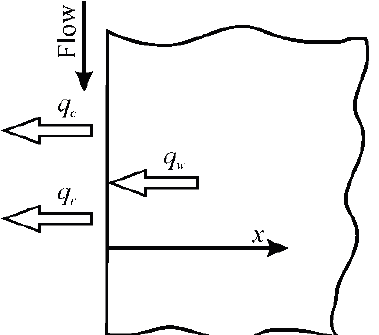
Figure 6. Sketch of the thin film sensor. Adapted from